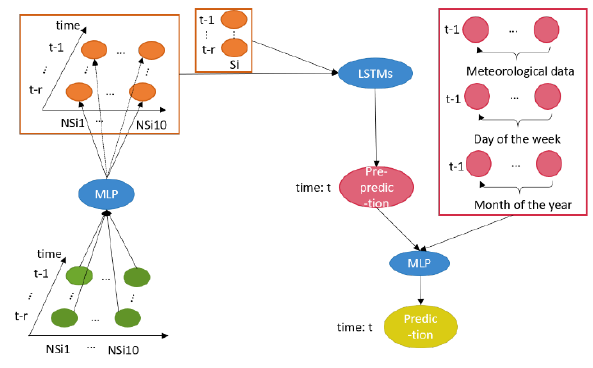
Figure 2 Framework of WWLSTME model.